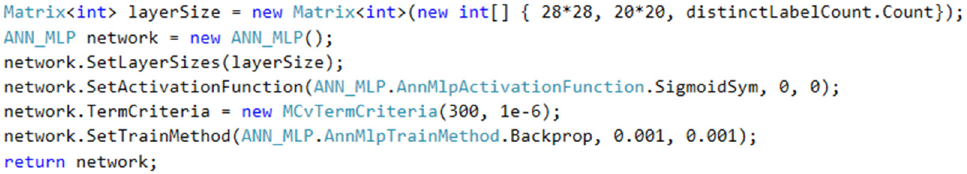
Figure 3. Code example: CreateNetwork method (own creation). LayerSize defines a numeric array of values representing the number and size of layers in a multilayer neural network, with the first element representing the input layer, the last output layer, and the values hidden between them. ANN_MLP is a class pro- vided by the EmguCV library, which is defined to instantiate it in program memory.